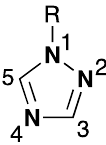
Figure 2. Atom numbering for signal assignment for 1,2,4-triazole.